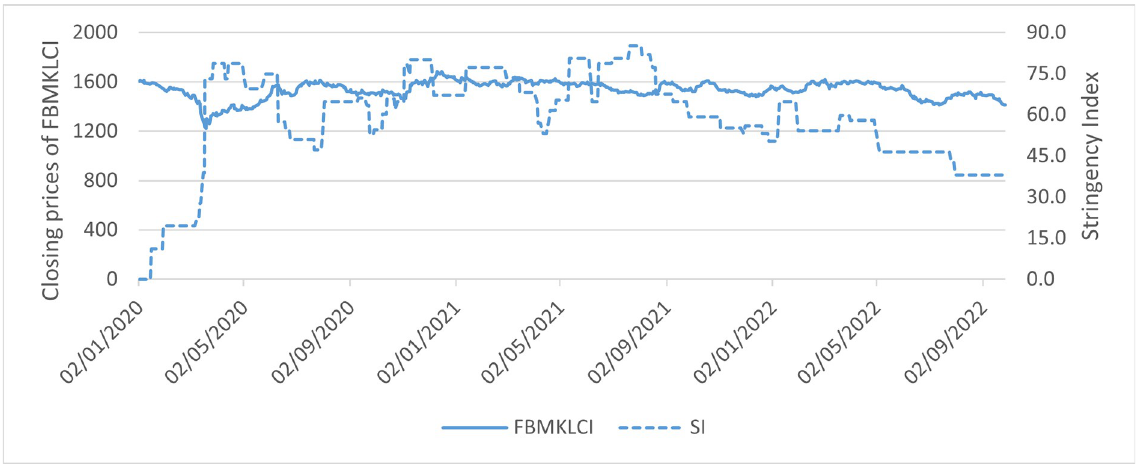
Fig 1. The time series plot of FBMKLCI closing prices and Stringency index from January 2, 2020 to September 26, 2022. Source: